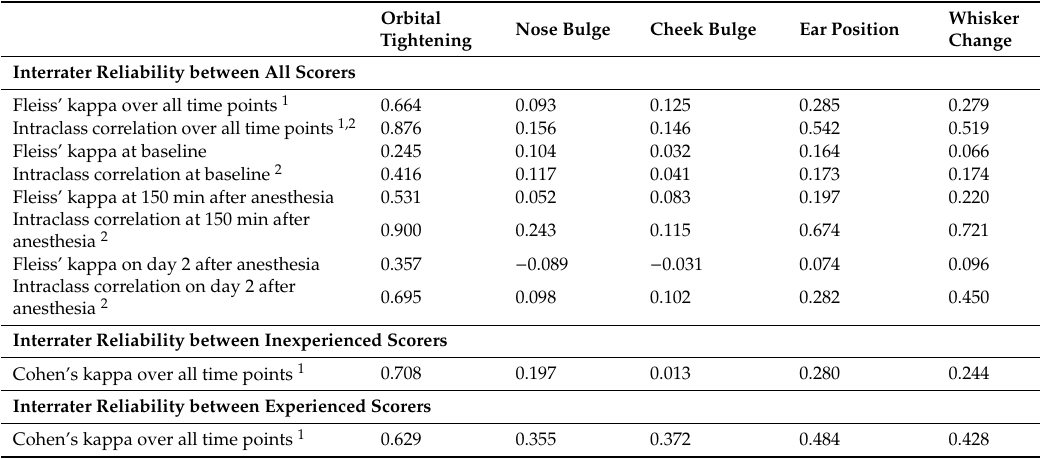
Table 2. Interrater reliability of each facial action